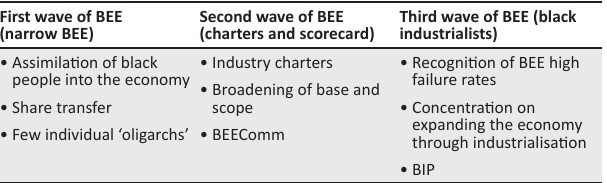
TABLE 2: Black Economic Empowerment waves or phases since